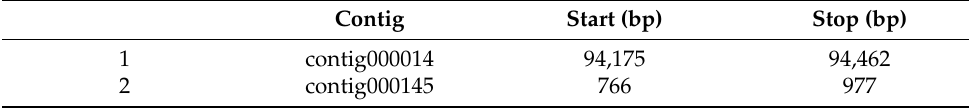
Figure A1. Cluster of Orthologous (COGs) for Microtetraspora sp. AC03309 analyzed using egg-NOG mapper v.2 [42]. CELLULAR PROCESSES AND SIGNALING [D] Cell cycle control, cell division, chromosome partitioning, [M] Cell wall/membrane/envelope biogenesis, [N] Cell motility; [O] Post-translational modification, protein turnover, and chap- erones, [T] Signal transduction mechanisms, [U] Intracellular trafficking, secretion, and vesicular transport, [V] Defense mechanisms [W] Extracellular structures, [Y] Nuclear structure, [Z] Cytoskeleton; INFORMATION STORAGE AND PRO- CESSING [A] RNA processing and modification, [B] Chromatin structure and dynamics, [J] Translation, ribosomal structure and biogenesis, [K] Transcription, [L] Replication, recombination and repair; METABOLISM [C] Energy production and conversion, [E] Amino acid transport and metabolism, [F] Nucleotide transport and metabolism, [G] Carbohydrate transport and metabolism, [H] Coenzyme transport and metabolism, [I] Lipid transport and metabolism, [P] Inorganic ion transport and metabolism, [Q] Secondary metabolites biosynthesis, transport, and catabolism; POORLY CHARACTERIZED [R] General function prediction only, [S] Function unknown. Table A1. Microtetraspora sp. AC03309 CRISPR array detected from CRISPRFinder